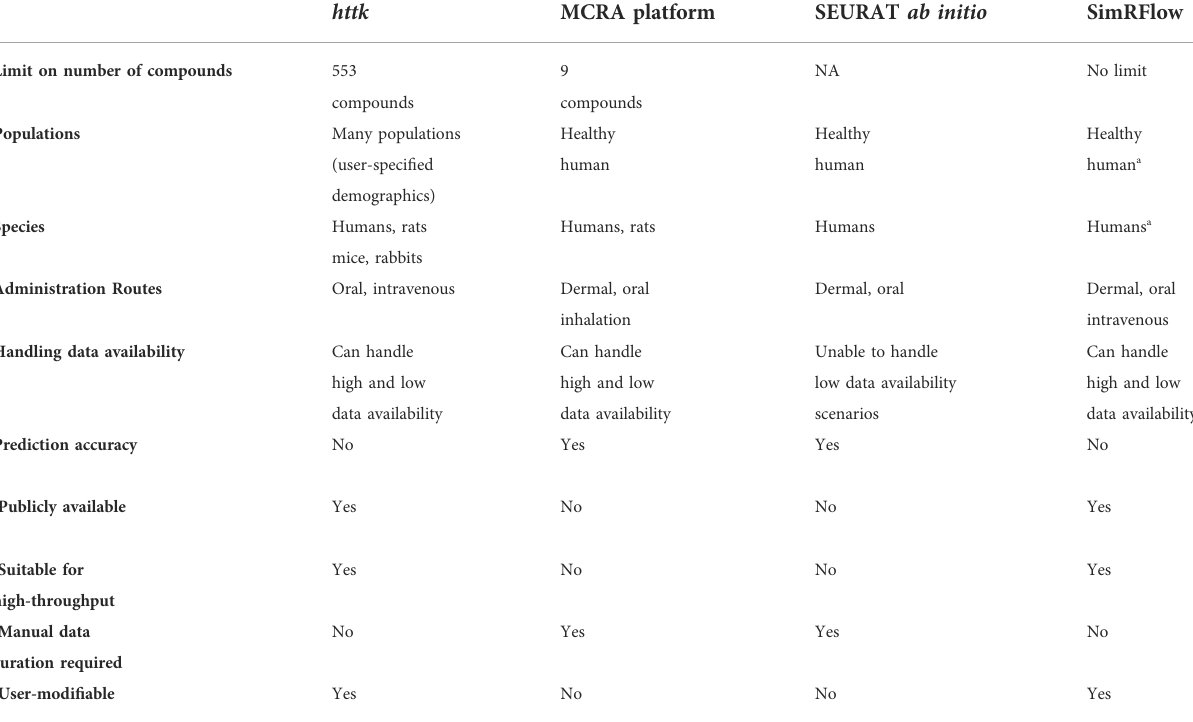
TABLE 5 Comparison of SimRFlow performance with that of httk , the MCRA Platform and SEURAT ab initio work fl